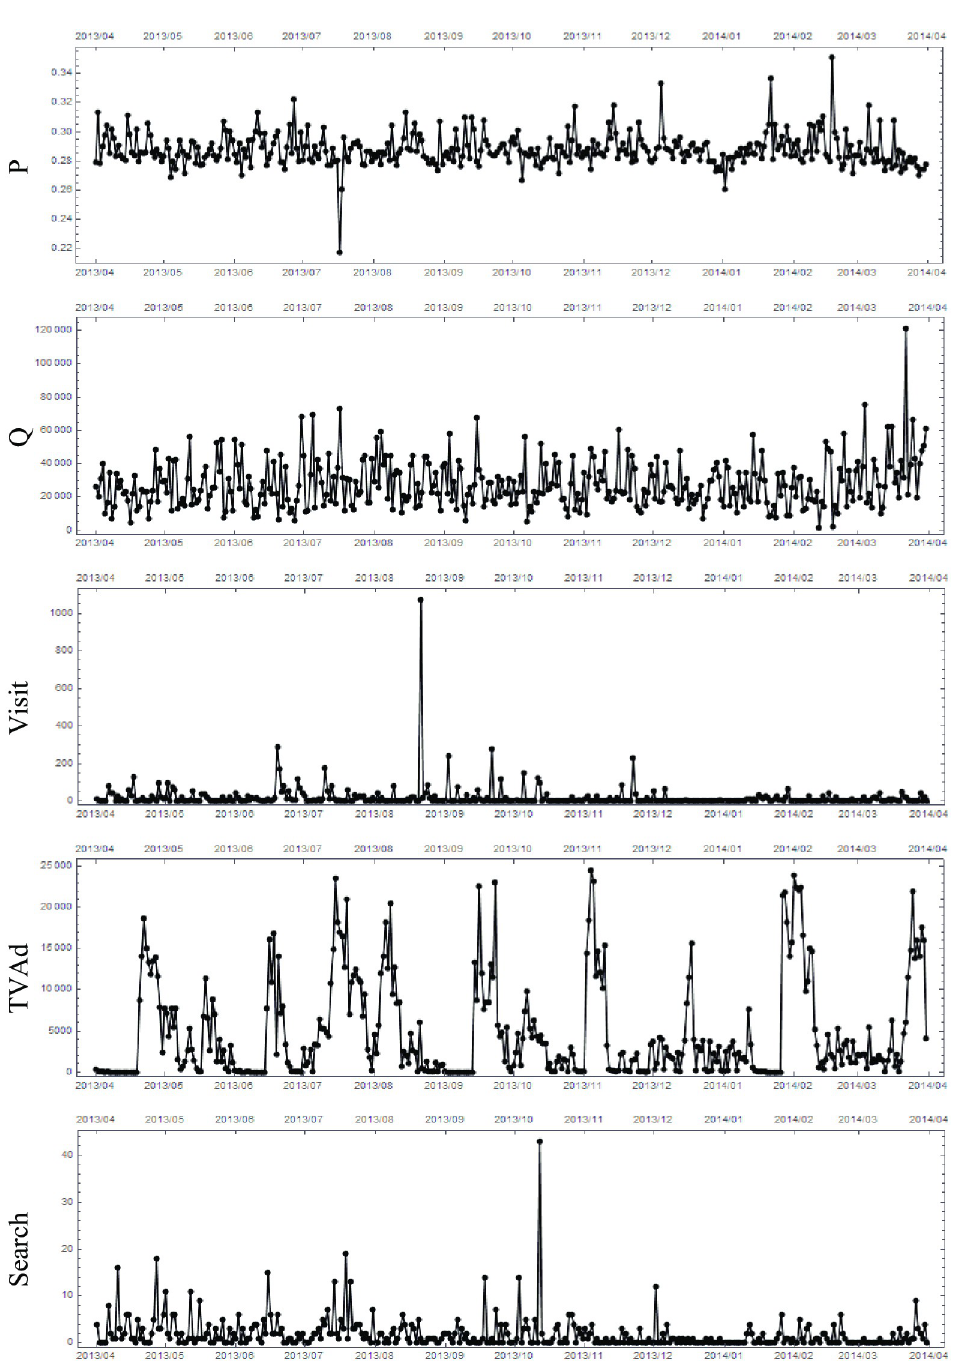
Fig 3. Sample of time-series. Time-series ~ x ð t Þ for the top product “D2” and for the five kinds of time-series, namely, a i P, Q, Visit, TVAd, and search are shown from top to bottom. https://doi.org/10.1371/journal.pone.0245531.g003 frequency of TV advertising exposure (TVAd) has weak periodic behavior presumably due to the TV advertising activities of the product’s firm and corresponding exposure to customers. The frequency of searches via PC or mobile device (Search) have continuous activities with bursts.